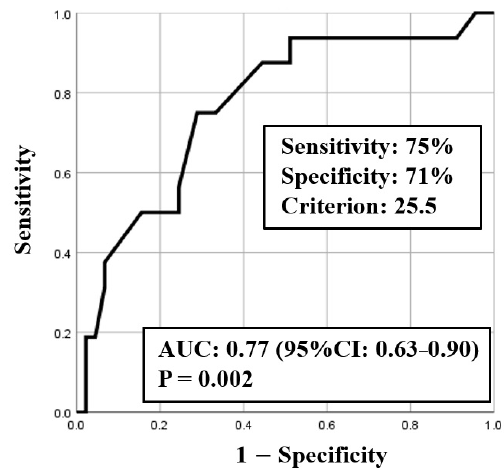
Figure 2. ROC curve for respiratory rate (RR).